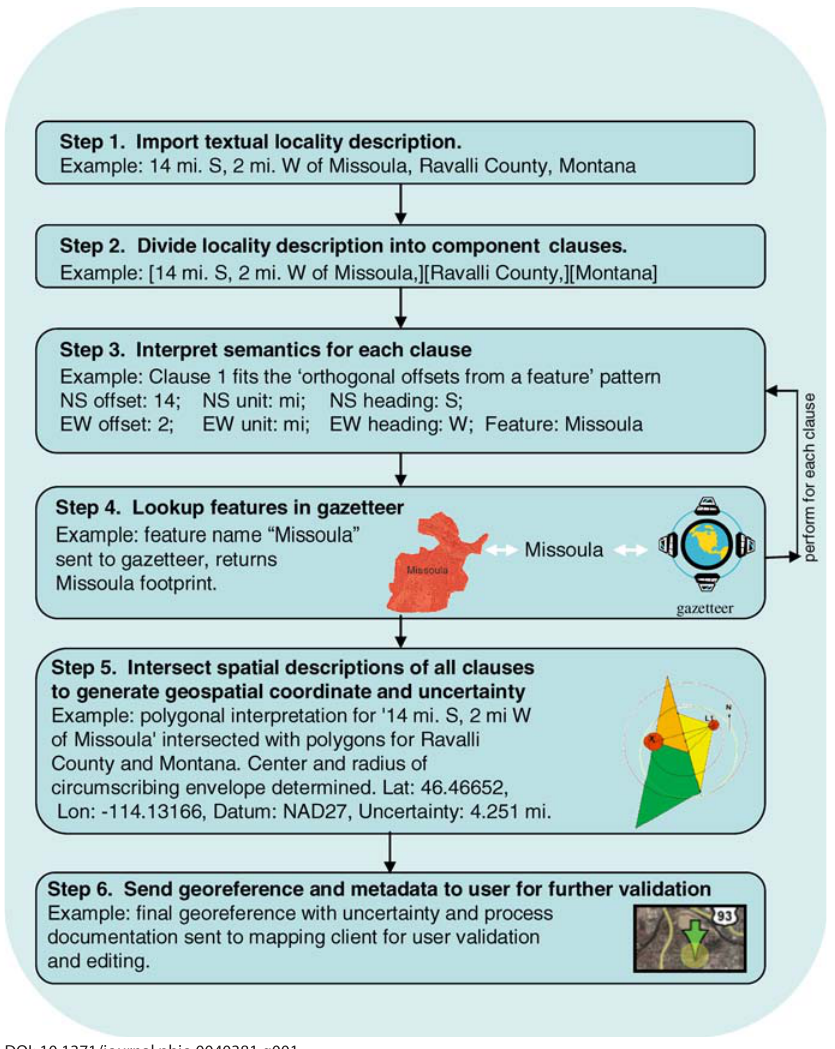
Figure 1. Diagram showing how BioGeomancer converts a textual locality description into a geospatial description suitable for use in geographic information